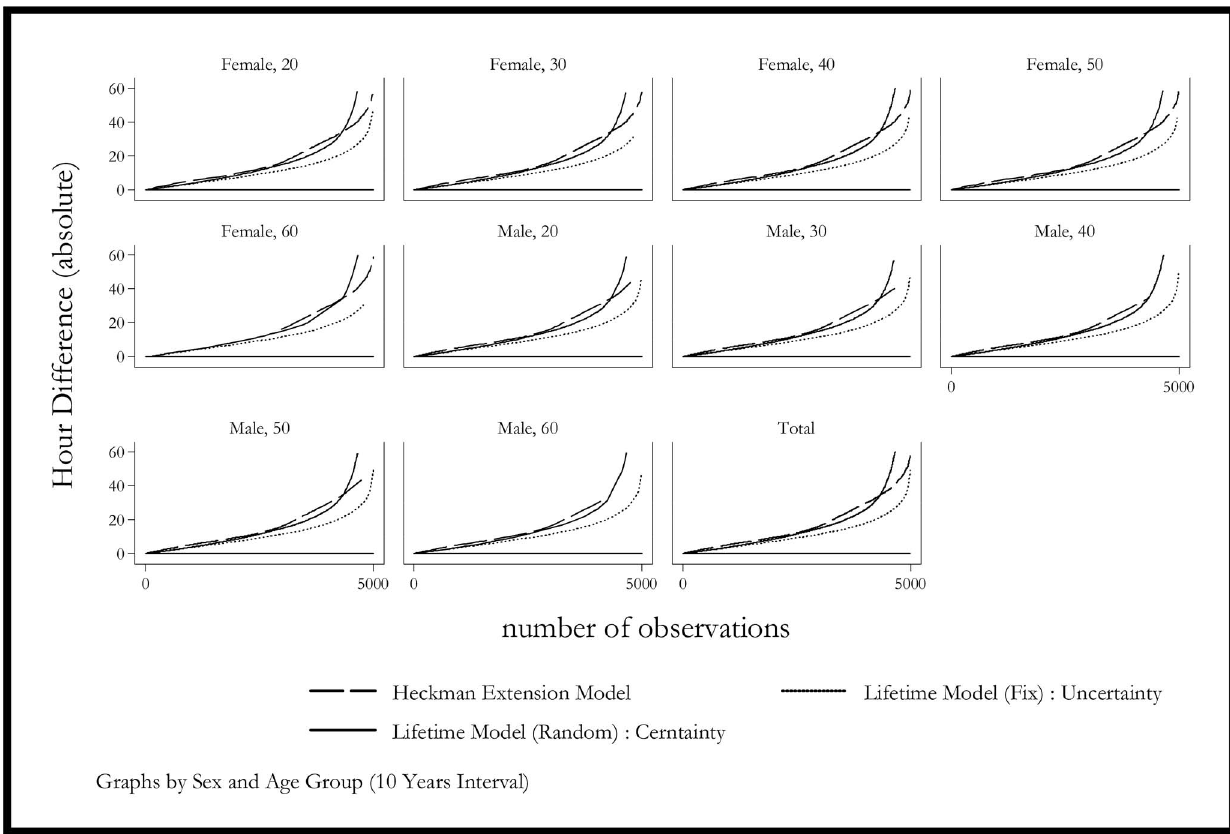
Figure 3. Simulation Residuals by Sex and Age - Selected Models (2004–2005). Dash Line: Heckman Selection Model. Solid Line: Lifetime Model (Random Coefficient): Certainty. Dot Line: Lifetime Model (Fix Coefficient): Uncertainty.